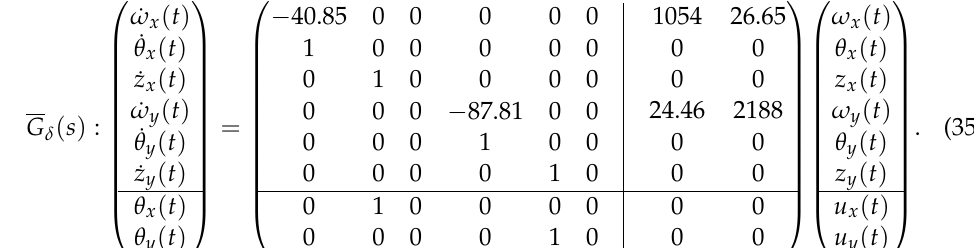
Table 1. Nominal values of the system’s parameters, along with their uncertainty ranges. Nominal Percentage Parameter Parameter Value T M 0.0245 ± 10% 25.8017 x T M y